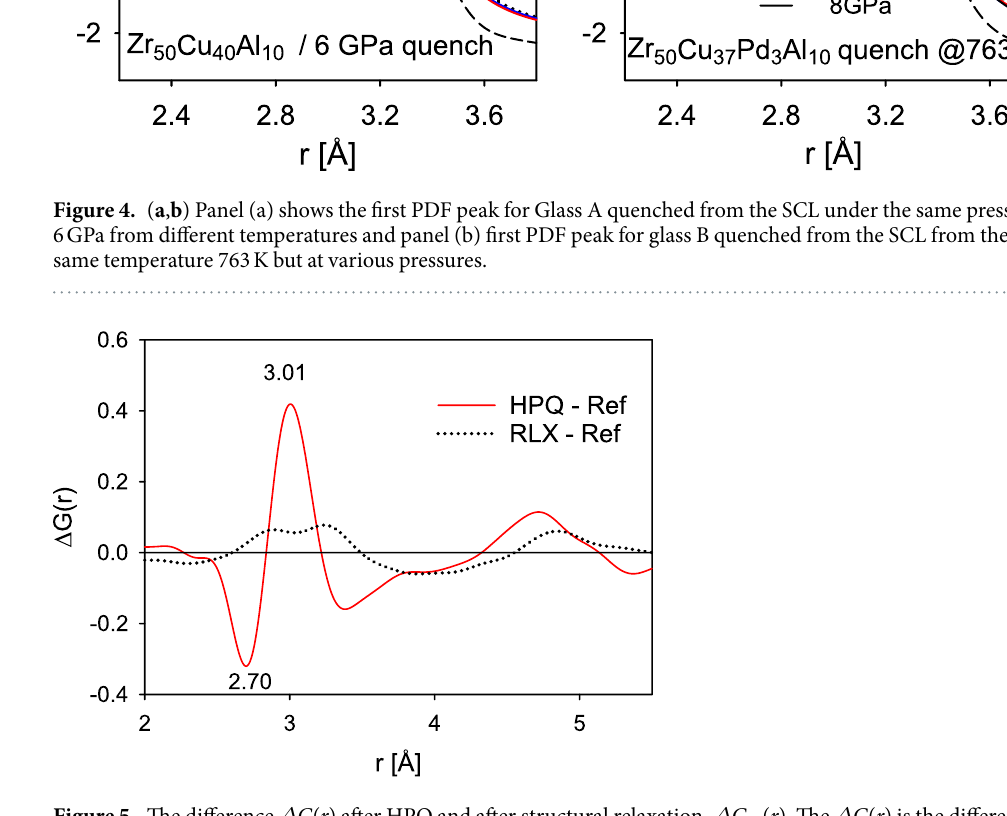
Figure 5. The difference Δ G ( r ) after HPQ and after structural relaxation, Δ G SR ( r ). The Δ G ( r ) is the difference between HPQ and the as cast sample and the Δ G SR ( r ) is the difference in G ( r ) between the sample annealed at T g and the as cast